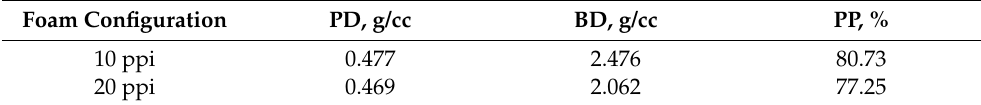
Table 4. Porosity of foams.